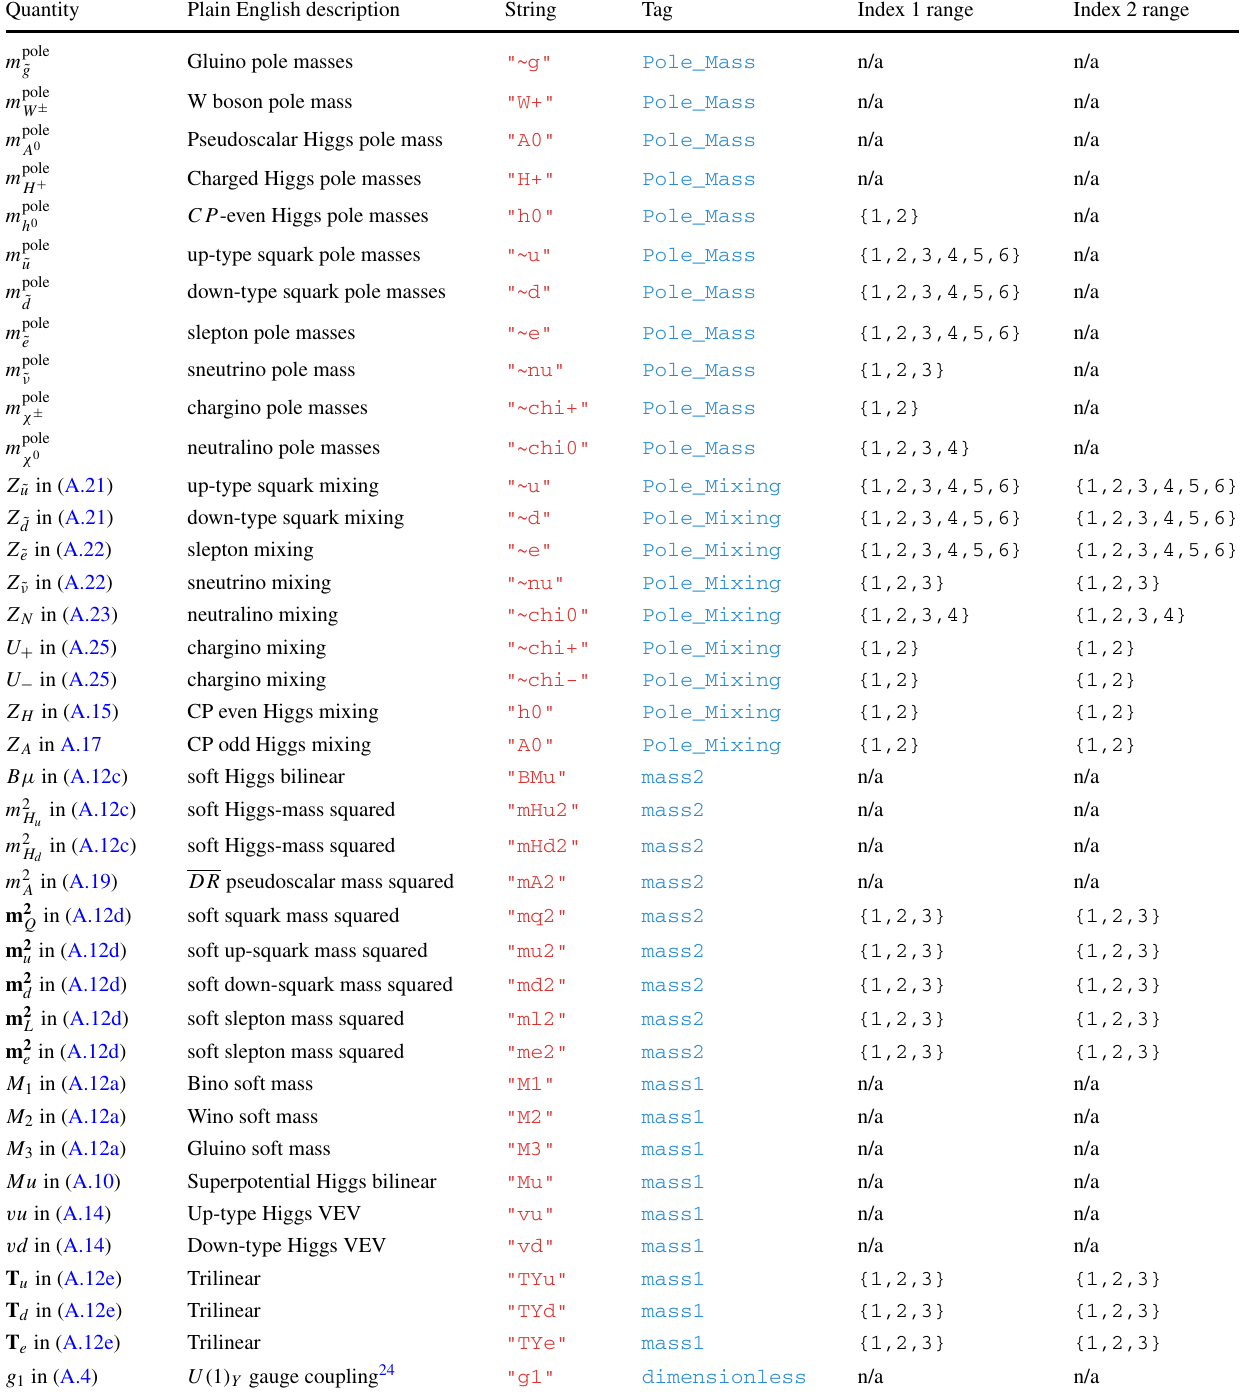
as in Sect. 2.3.3. The final two arguments are optional and are filled when necessary by the indices from the allowed range given in the last two columns. Note that weak mixing angle here is defined in the DR scheme and is simply reconstructed from the gauge couplings using the expression given in Eq.